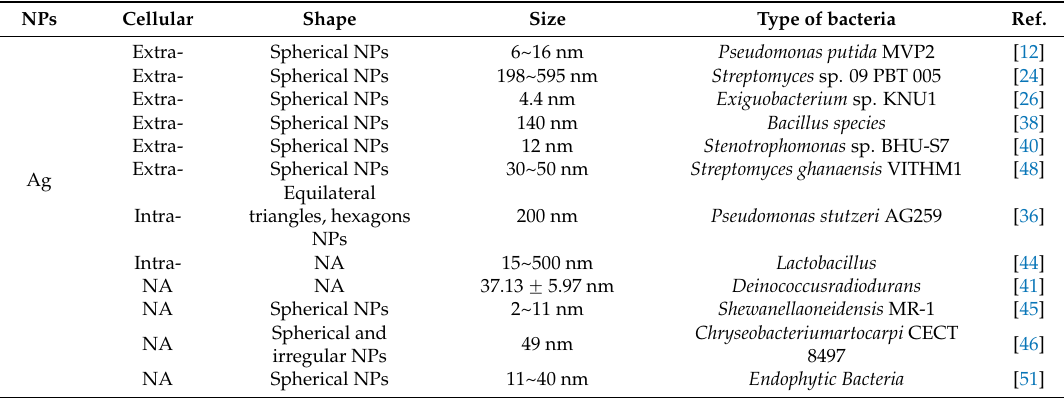
Table 1. Elementary substances synthesized by